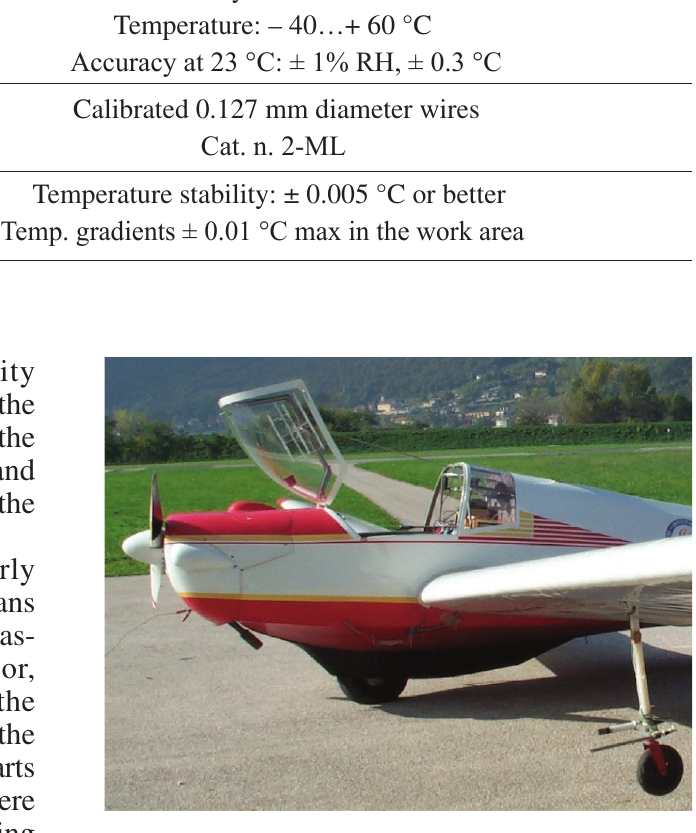
Fig. 3. A close look at the sensors outside the mo- torglider on the left undercarriage leg.